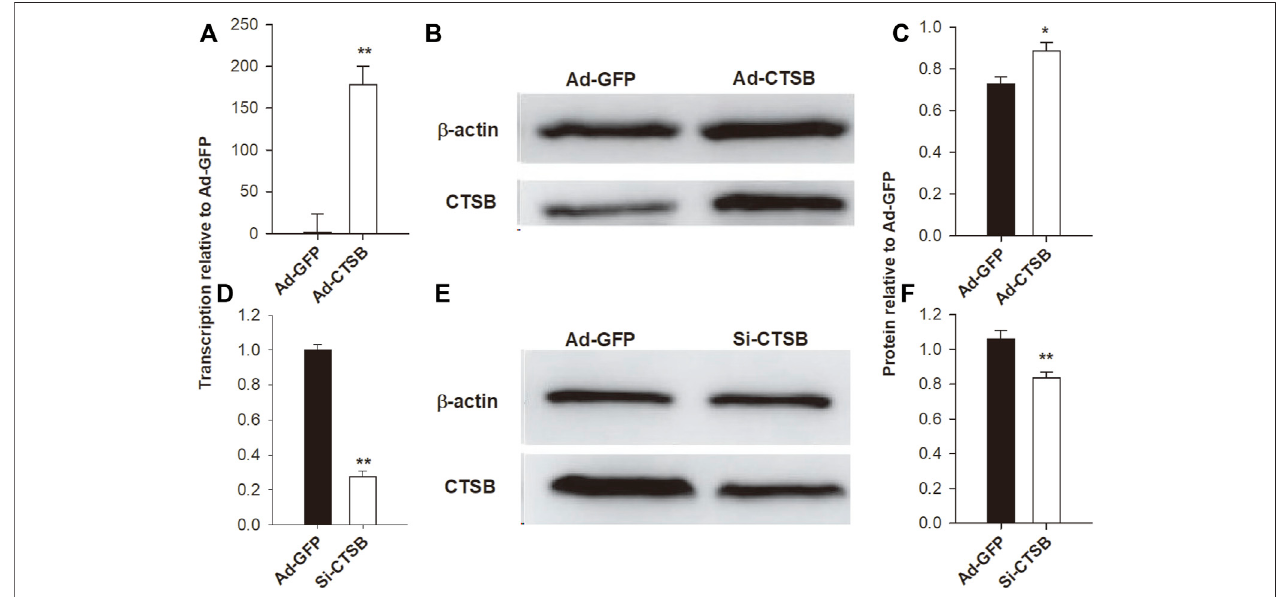
FIGURE5| Adenovirus-mediatedoverexpressionandsiRNA-mediatedinterferenceof CTSB inrabbitGCS.ThetranscriptionofmRNA via RT-qPCR (A,D) andthe protein expression via Western blot (B,C,E,F) of CTSB were highly affected by overexpression and interference treatments. Each experiment was performed with three biological replicates, and the results are expressed as the mean ± SEM. * p < 0.05, ** p < 0.01.